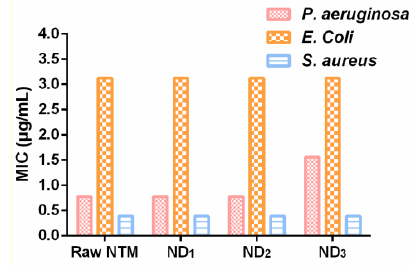
Figure 7. Minimum inhibitory concentrations of different NTM DPIs ( n = 6).